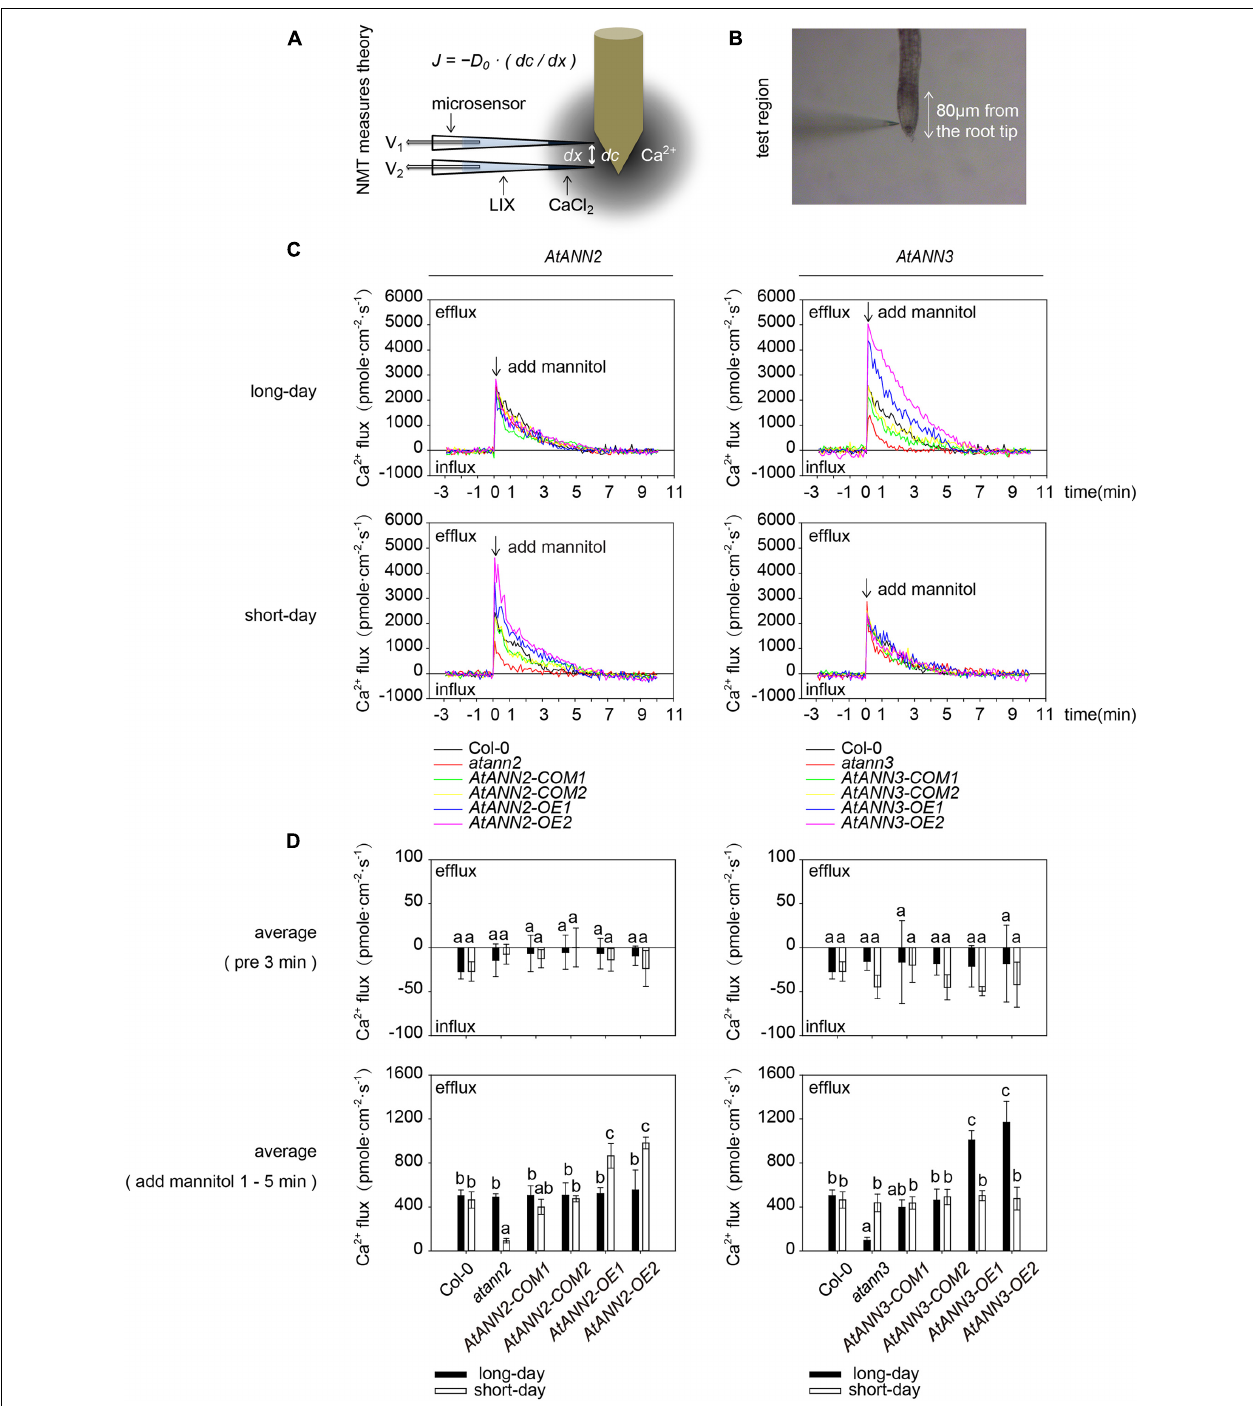
FIGURE 5 | Regulation of transmembrane Ca 2 + flow by AtANN2 and AtANN3 in response to mannitol treatment under different photoperiods. (A) Theory of the NMT system. According to a predefined fashion, the concentration gradient of specific ions was measured between two points near the sample by using an ion microsensor. The ionic fluxes were calculated based on Fick’s law of diffusion as follows: J = − D 0 · ( dc / dx ), where J is the ion flux (unit: pmole · cm − 2 · s − 1 ), dc is the concentration gradient, dx is the distance between the two points, and D 0 is the diffusion constant. (B) The main root meristematic zone (within approximately 80 µ m from the root tip) of Arabidopsis seedlings was used as the test area. (C) Net Ca 2 + fluxes at the meristematic zone in response to 300 mM mannitol applied as indicated by the arrow. Positive values indicate Ca 2 + efflux. (D) Mean Ca 2 + flux values from 1 to 5 min after 300 mM mannitol treatment and the control (pre 3 min) ( n = 5). Different letters indicate significant differences with each treatment at p <0.05 level.